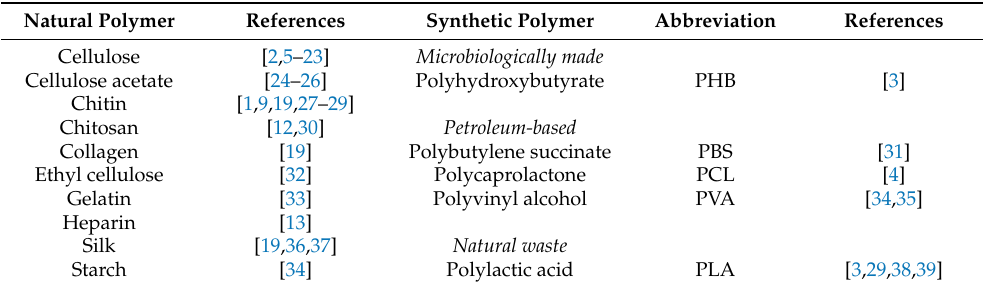
Table 1. Examples of natural and synthetic biodegradable polymers employed for the preparation of electrospun fibers.